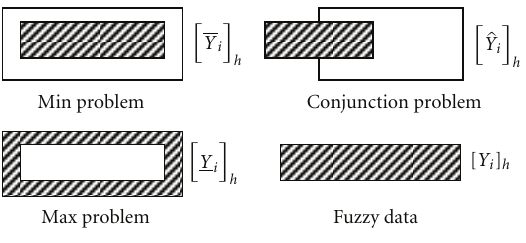
Figure 1: The concepts of three